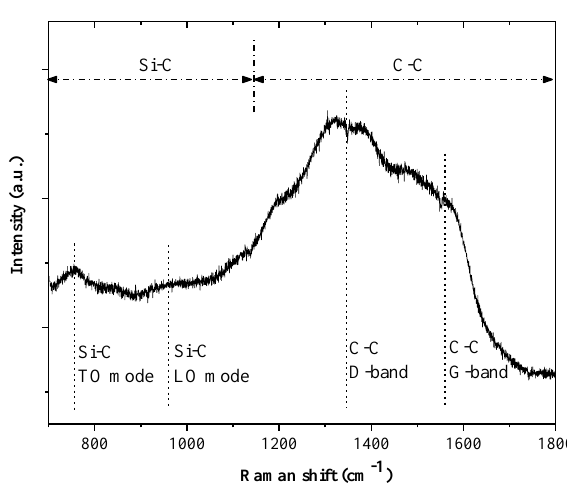
Figure 7. Raman spectrum of Si-DLC.